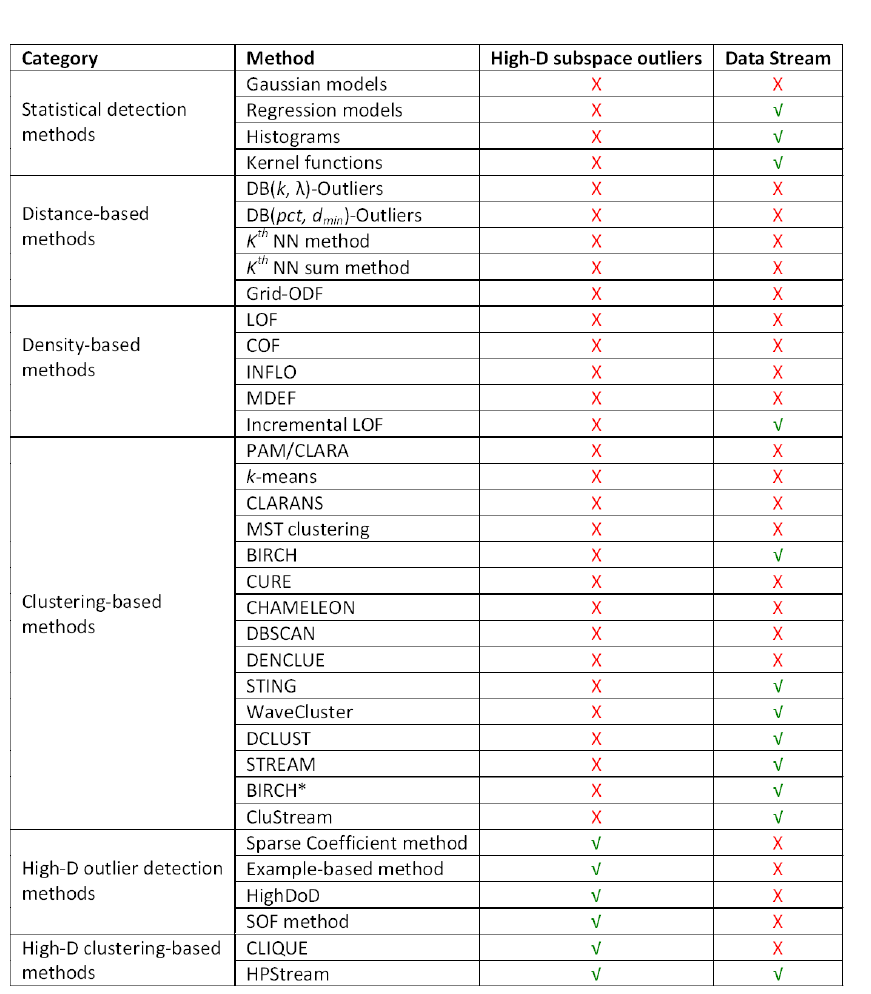
Figure 6. A summary of major existing outlier detection